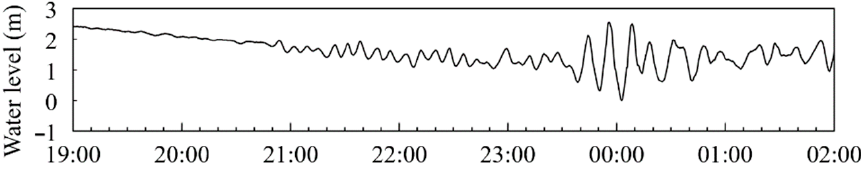
Figure 13. The tide-gauge record obtained at Kominato, Amami, Kagoshima, Japan from 19:00 on 15 January to 02:00 on 16 January 2022 (JST). Information from the Japan Meteorological Agency was used to create the figure.